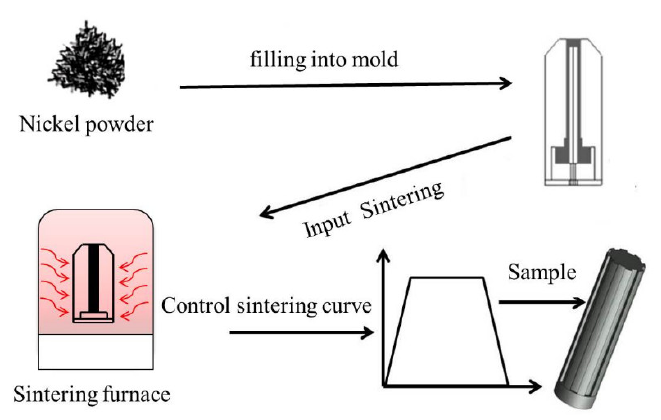
Figure 3. Wick manufacture process.